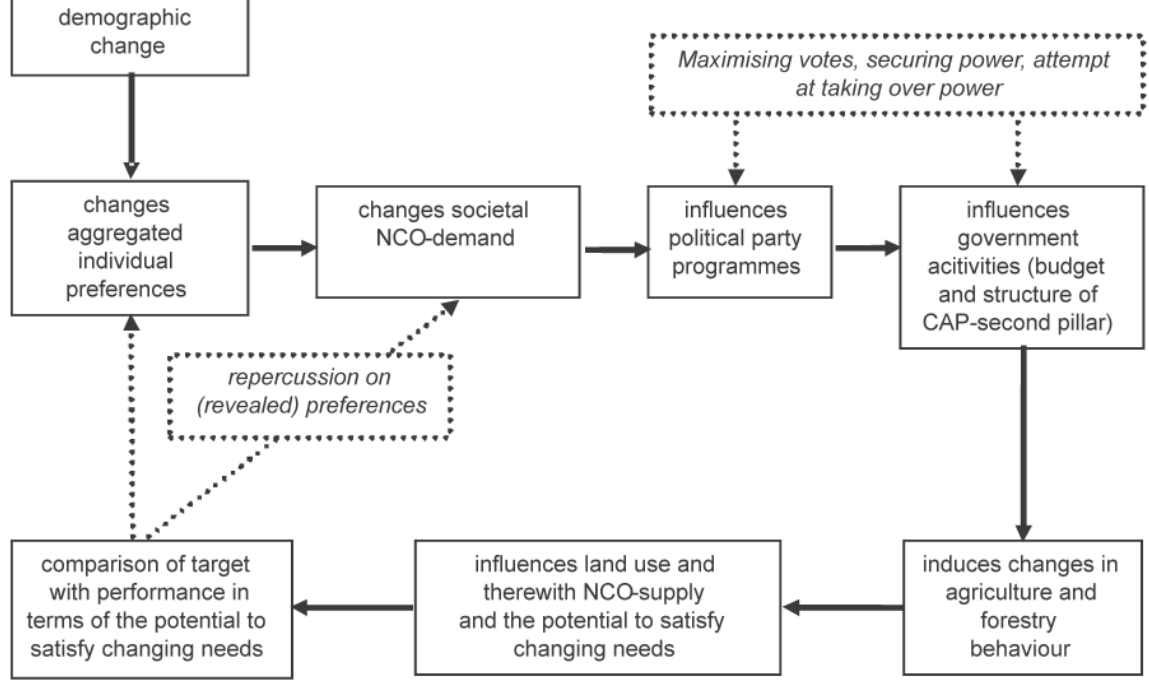
Figure 4. Politico-economic cause-effect relationships (Source: own